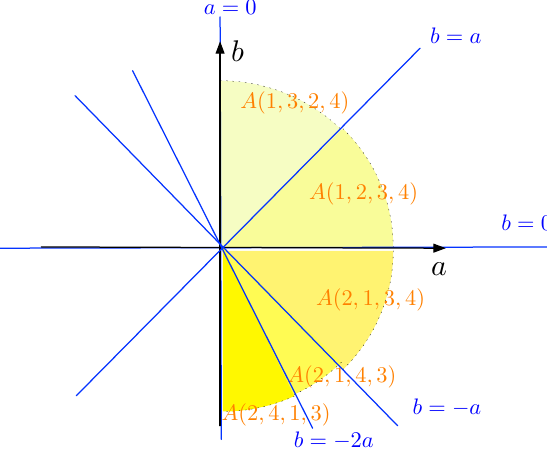
Figure 3. The ( a , b ) -plane is partitioned (apart from shared borders) in ten unbounded pie-shaped slices (the sets A ( i 1 , i 2 , i 3 , i 4 ) in different shades of yellow), which are determined by the lines a = 0, b = 0, b = a , b = a and b = 2 a (in blue). The slices above the negative a -axis are not shown, but can − − be obtained via Property